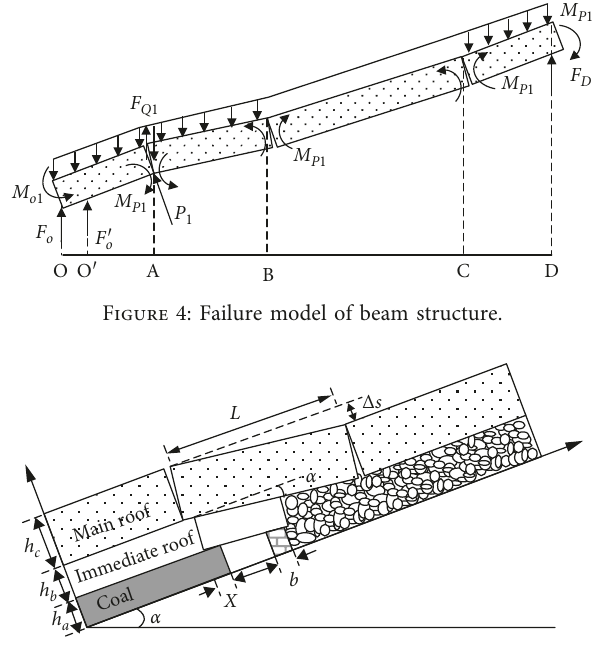
Figure 5: Compressibility model of